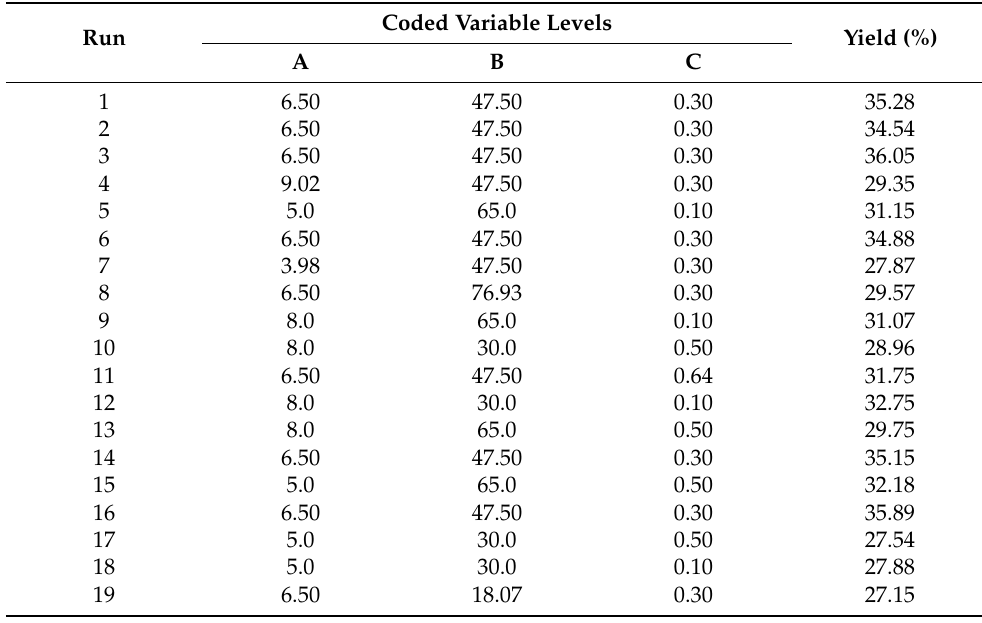
Table 2. Box–Behnken response surface design scheme and